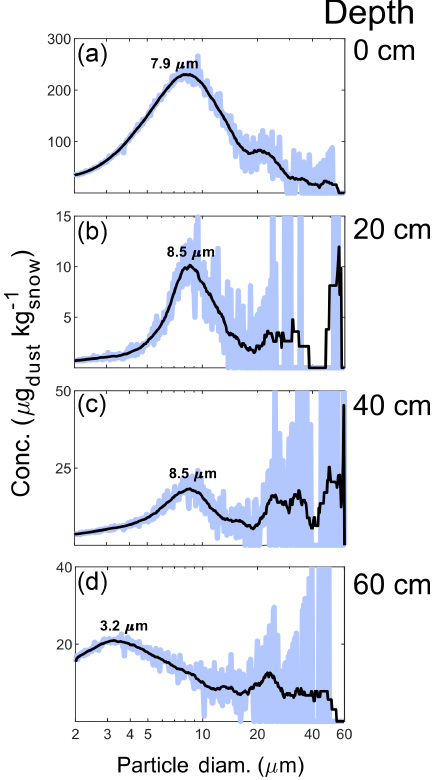
Figure 5. Dust particle distribution (expressed in µg dust kg − 1 snow ) for a snow profile sampled at Torgnon on 6 April at different depths (0, 20, 40, and 60cm). Blue lines are experimental data, and black lines are moving averages (kernel: 25 points). Numbers in the plots represent the peak of the size distributions. Please note that the scale changes within different plots.